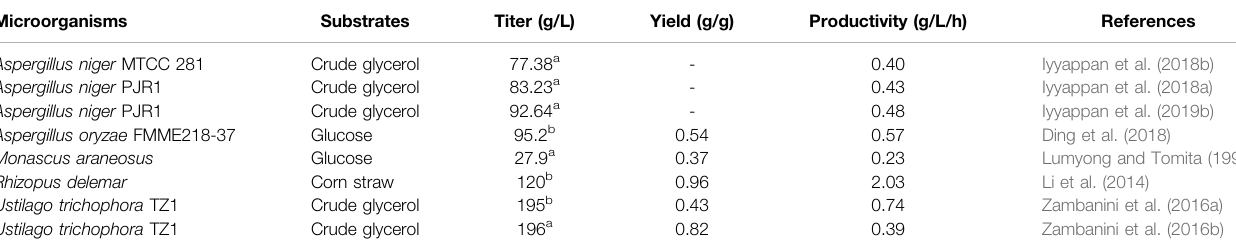
TABLE 2 | Malic acid production by mutants and evolutionarily engineered microorganisms.